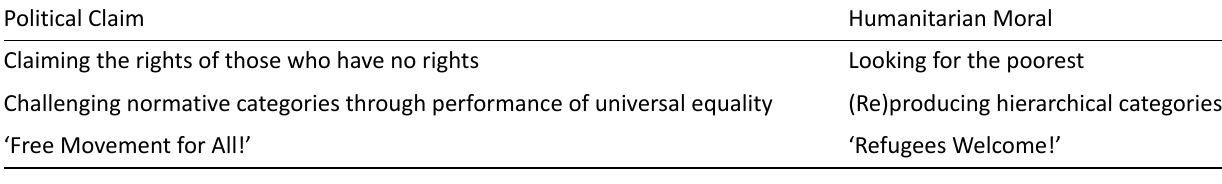
Table 1. Political claim vs. humanitarian moral. Political